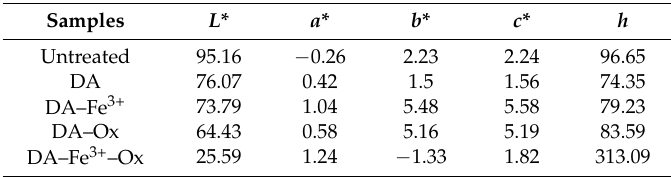
Table 1. Color characteristic values of silk samples.